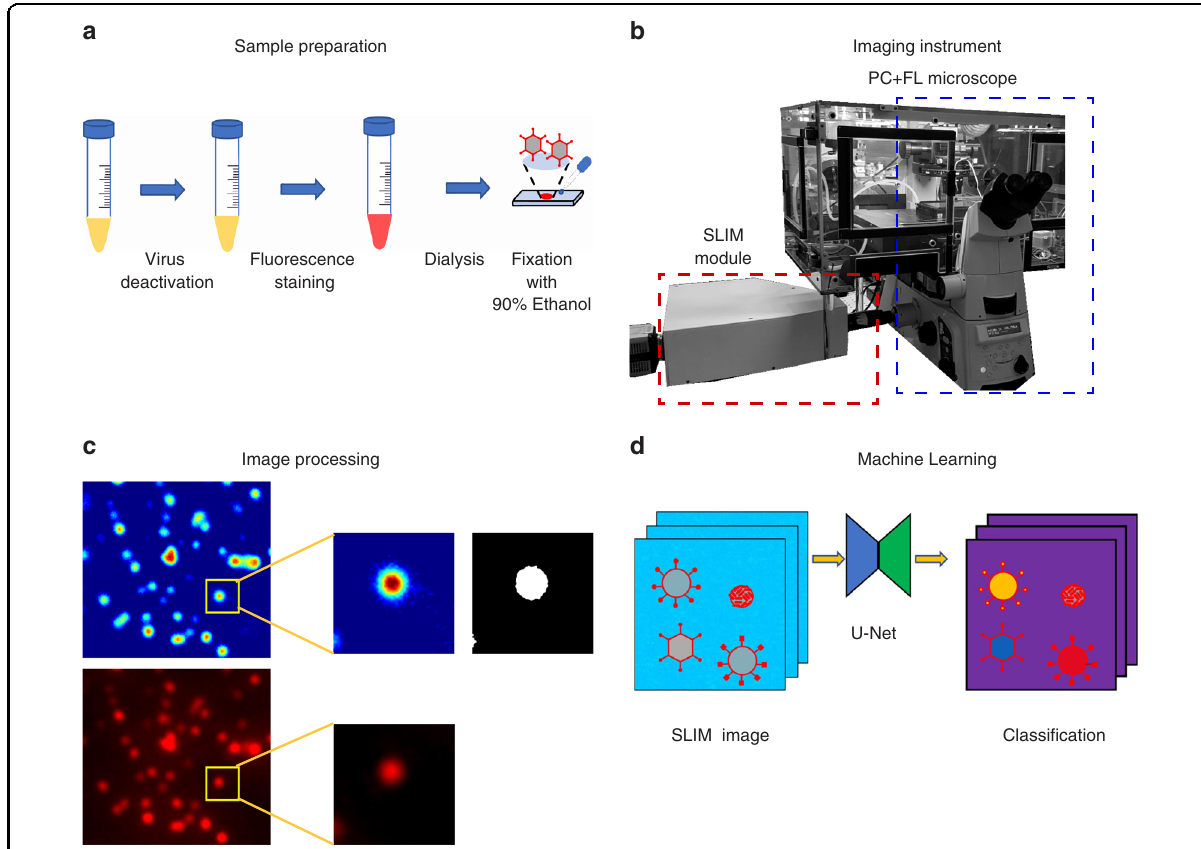
Fig. 1 Virus-particle classi fi cation using SLIM and machine learning. a Sample-preparation protocol, viruses were deactivated, stained with Rhodamine B isothiocyanate, and dialyzed for two days to reduce fl uorescence background, and then placed on a slide, fi xed with 90% EtOH, and air- dried. b We added a SLIM module to a traditional phase-contrast microscope for quantitative-phase information. c SLIM and fl uorescence were registered, single 48 × 48 spots were cropped from the image and segmented to provide a label for multiclass classi fi cation. d We synthesized a new dataset by randomly placing the cropped virus particles onto a background image acquired during the same experiment. A deep neural network was trained with this dataset to perform virus-particle classi fi cation. Given a SLIM image, the model will output a class label for each pixel in the